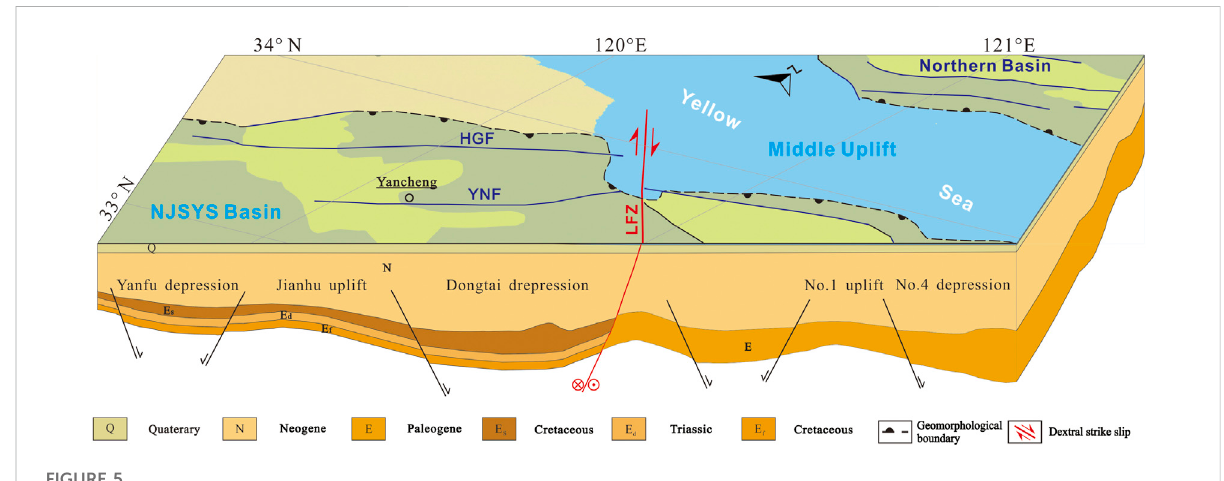
FIGURE 5 Cross-section of the littoral Fault. Geological information was taken from Yao et al., 2008 and Liu et al., 2014. See Figure 1B for the location of section a – a ’